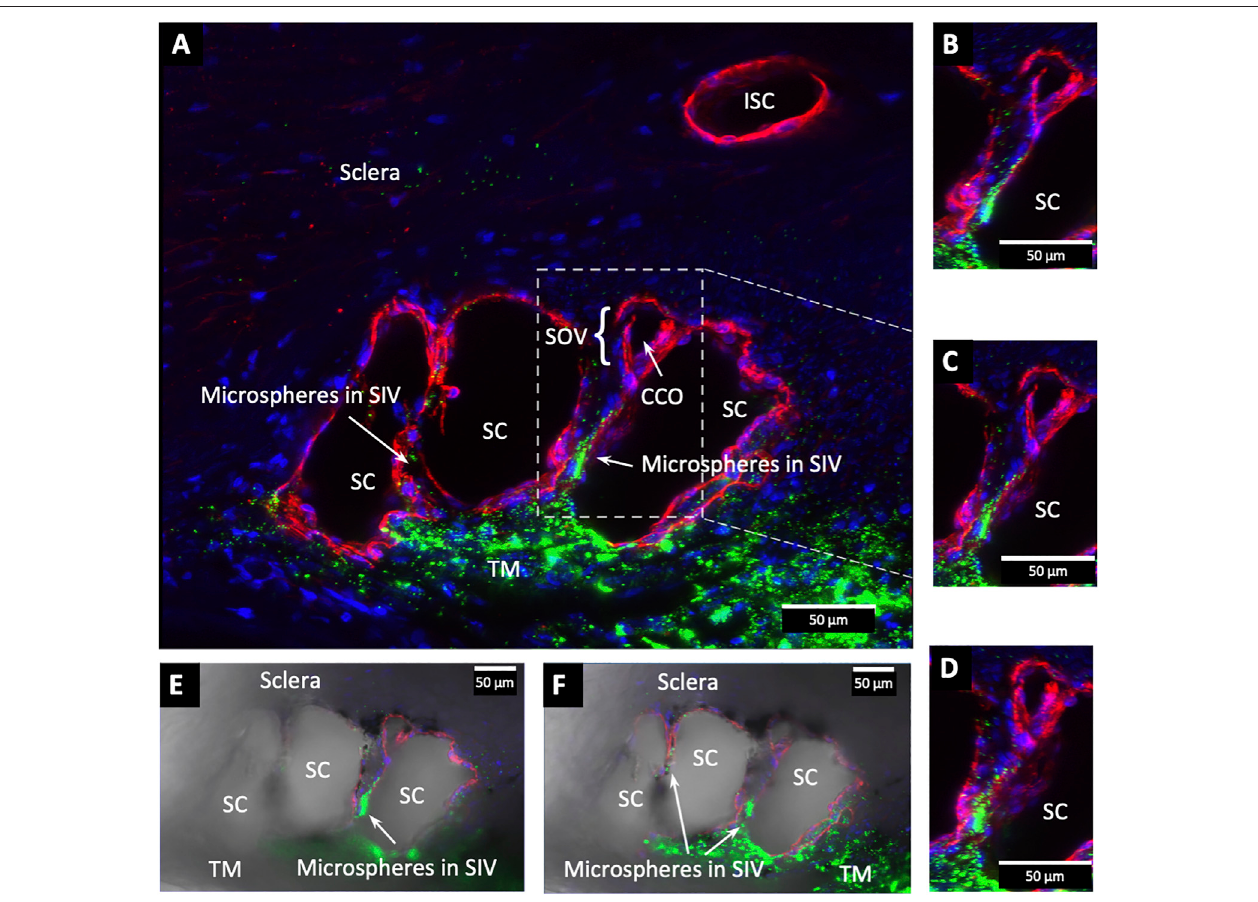
FIGURE9| FluorescentmicrospheresenteringandexitingSchlemm ’ scanalinletvalve-likestructures. (A) MergedCD31(red),DAPI(blue),and500 nm fl uorescent microsphere (green) channels. TwoSchlemm ’ scanal (SC) valve-like structures(SIV) attach tothe externalwall ofSC. The complexdistal attachment creates a valve-like structureattheSCoutlet(SOV). (B – D) SameSOVstructurerotatedaroundtheY-axis. (E – F) MergedIHCchannelsaddtheNomarskiviewtobettershowthestructureof the SIV and their attachments to the distal wall of SC Supplementary Video S2 #43LIT12.